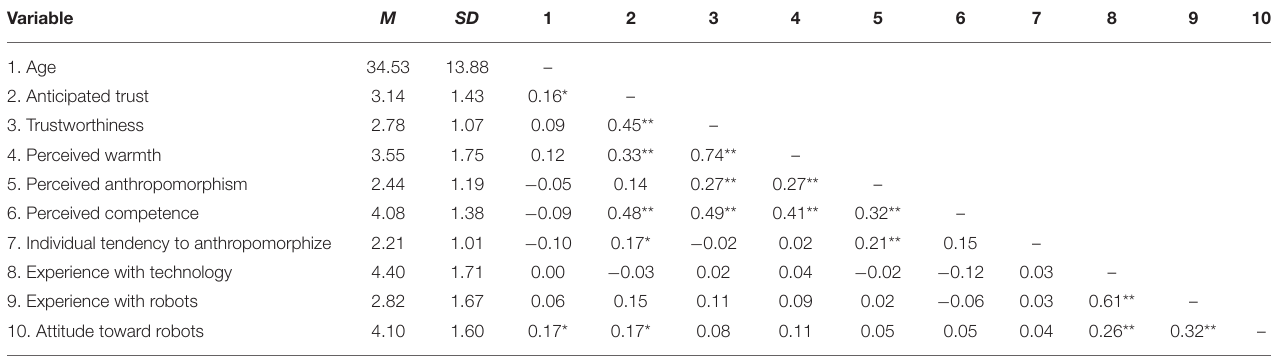
TABLE 7 | Means ( M ), standard deviations ( SD ), and Pearson correlations of relevant variables within the overall sample of study 2. Variable M SD